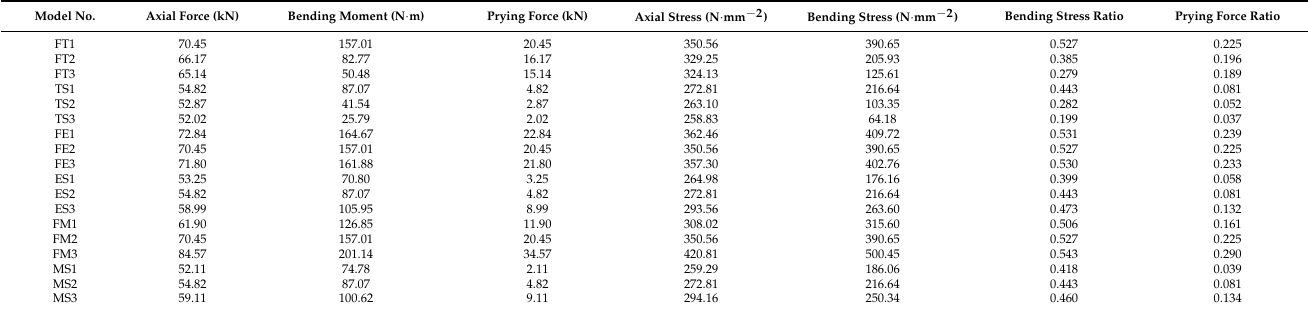
Table 5. Bolt internal force under different